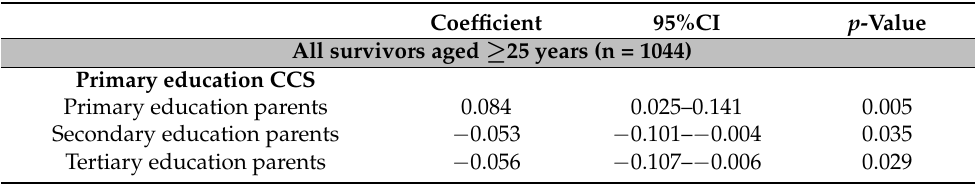
Table 3. Multivariate regression analysis evaluating the association between highest parental educa- tional level and highest educational level achieved in childhood cancer survivors aged ≥ 25 years at survey, stratified by diagnostic group.